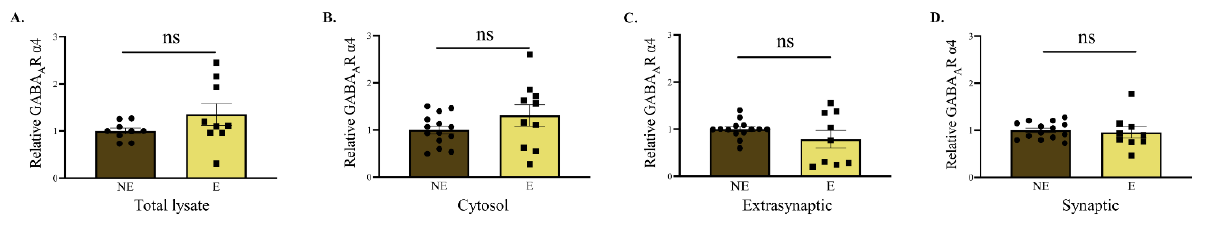
Figure 8. WB analyses of biochemically isolated fractions from primary SoCx for GABA A R α4, α5 , and δ subunits. Subcellular fractions were isolated from the control (NE) littermates and epileptic (E) stargazers. ( A − D ) Biochemical fractionation analysis revealed no significant change in GABA A R α4 in all subcellular components from th e primary SoCx of stargazers compared to their NE littermates: total lysate (NE: 1.000 ± 0.063 [ n = 9], E: 1.353 ± 0.227 [ n = 9]; p = 0.257), cytosol (NE: 1.000 ± 0.088 [ n = 14], E: 1.308 ± 0.223 [ n = 10]; p = 0.172), extra-synaptic (NE: 1.000 ± 0.051 [ n = 14], E: 0.789 ± 0.183 [ n = 9]; p = 0.516), and synaptic (NE: 1.000 ± 0.047 [ n = 14], E: 0.955 ± 0.122 [ n = 9]; p = 0.369). ( E − H ) GABA A R α5 analysis revealed no significant change in all subcellular components from the primary SoCx of stargazers compared to their control littermates: total lysate (NE: 1.000 ± 0.094 [ n = 10], E: 0.919 ± 0.102 [ n = 10]; p = 0.566), cytosol (NE: 1.000 ± 0.113 [ n = 14], E: 1.295 ± 0.362 [ n = 8]; p = 0.920), extra-synaptic (NE: 1.000 ± 0.068 [ n = 13], E: 1.324 ± 0.214 [ n = 9]; p = 0.431) and, synaptic (NE: 1.000 ± 0.075 [ n = 13], E: 1.190 ± 0.195 [ n = 9]; p = 0.744). ( I − L ) No statistically significant change was also seen for GABA A R δ subunit in all subcellular components from the primary SoCx of stargazers compared to their control littermates: total lysate (NE: 1.000 ± 0.071 [ n = 15], E: 1.088 ± 0.201 [ n = 9]; p = 0.815), cytosol (NE: 1.000 ± 0.083 [ n = 15], E: 0.831 ± 0.138 [ n = 9]; p = 0.379), extra- synaptic (NE: 1.000 ± 0.078 [ n = 15], E: 1.419 ± 0.241 [ n = 10]; p = 0.191), and synaptic (NE: 1.000 ± 0.053 [ n = 15], E: 1.092 ± 0.094 [ n = 9]; p = 0.263). The significance threshold was set at 0.05. ‘ns’ indicates no significant change found from analyses. 2.5. PV + Feed-Forward Inhibitory Interneurons Show No Overall Change in Synaptic GABA A R α1 Since biochemical fractionation revealed that GABA A R α1 was significantly reduced in synaptic fractions from stargazers, the next step was to determine if the subunit was reduced specifically at synapses between PV + feed-forward interneurons and their targets. PV + neurons synapse onto the soma, proximal dendrites, and axonal initial regions of the pyramidal cells [65], which are their primary targets in the SoCx. However, they also show a high degree of reciprocal connectivity with each other and other inhibitory interneurons [66]. Double-labelled ICC-EM of primary SoCx sections with 10 nm immunogold for